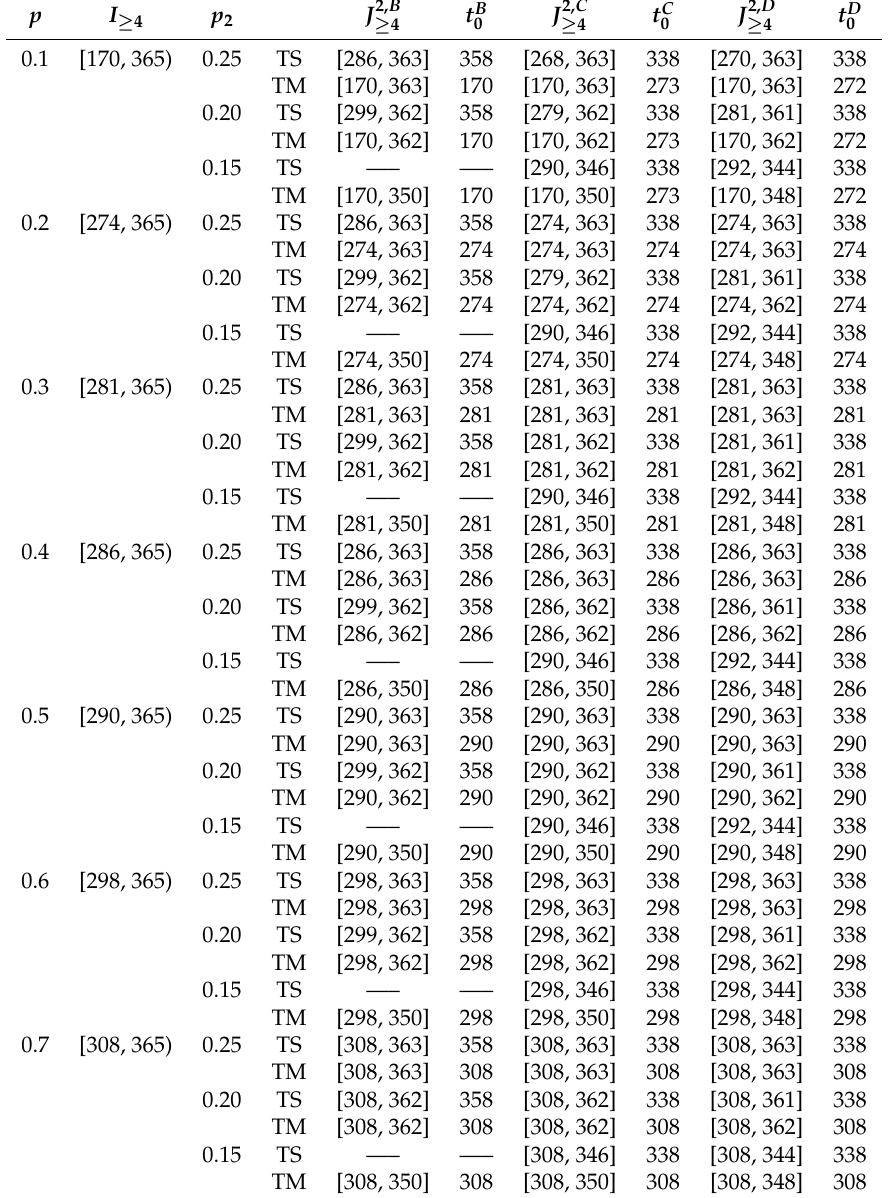
Table A3. Intervention instants t 0 versus the index p and the upper bound p 2 for the cost of intervention (Criterion 2) for m (cid:48) = 4. Grazing strategies TS and TM with the anthelmintics ivermectin (B), fenbendazole (C) and albendazole